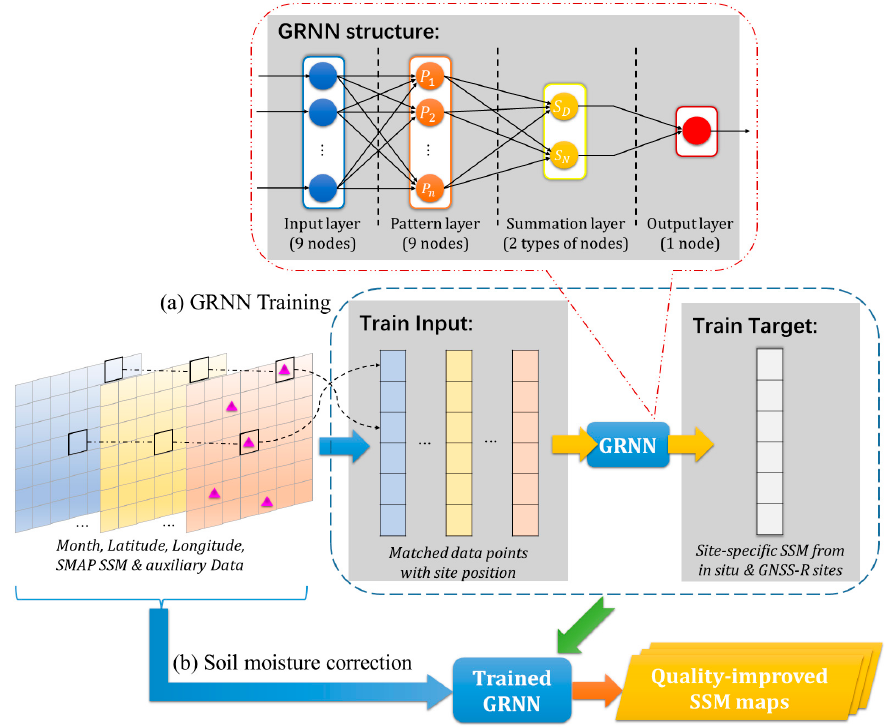
Figure 3. Schematic of the GRNN model used for SSM improvement and the two steps of the GRNN fusion approach: ( a ) GRNN training; and ( b ) soil moisture correction using the trained network.